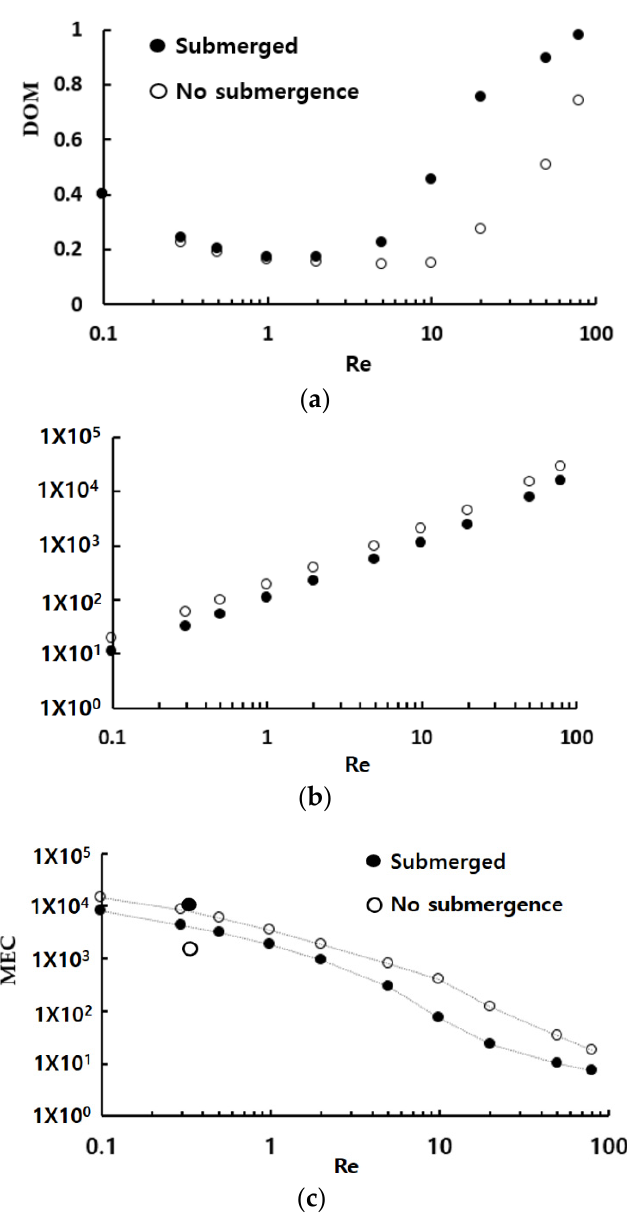
Figure 6. Mixing enhancement of submerged structures: ( a ) DOM vs. Re, ( b ) Δ P vs. Re, and ( c ) MEC vs. Re.